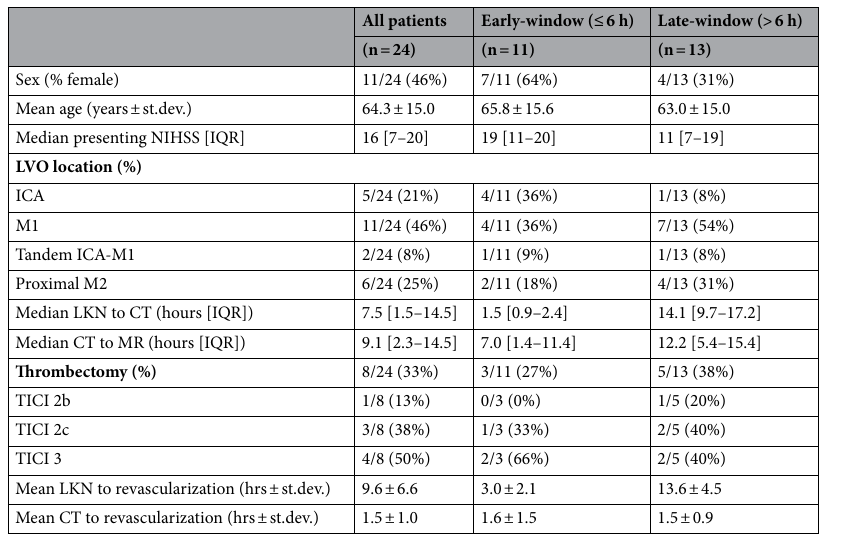
Table 1. Patient demographics and baseline imaging